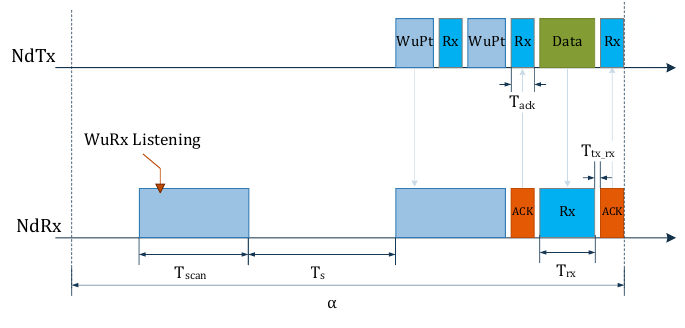
Figure 2. DCW-MAC scheme. WuPt, wake-up packet; Nd, node.